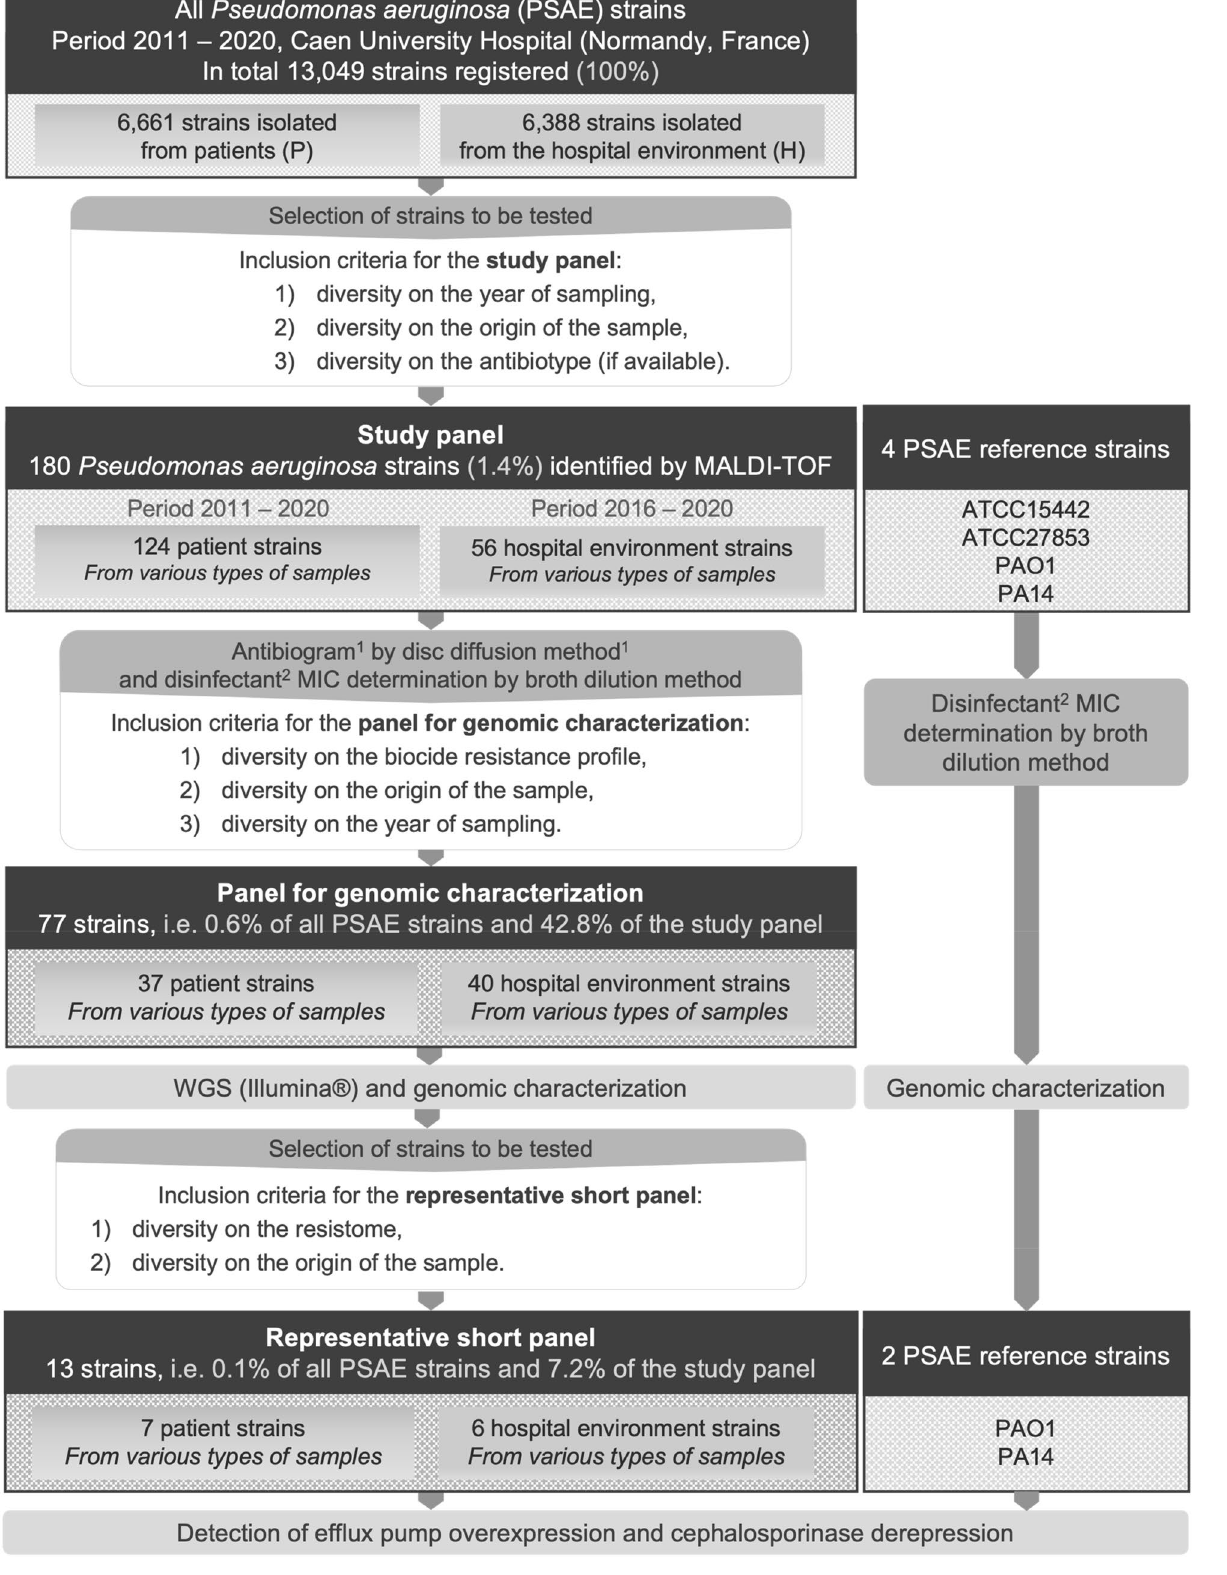
Figure 1. Selection diagram for the study and reference strains. 1 : 6 classes tested, i.e., 16 antibiotics for hospital use; 2 : didecyldimethylammonium chloride, ATCC, American Type Culture Collection; H, Strains isolated from the hospital environment; MALDI-TOF, Matrix Assisted Laser Desorption Ionisation/Time of Flight; P, Strains isolated from patients; PSAE, Pseudomonas aeruginosa ; UHC, University Hospital Center; WGS, Whole Genome